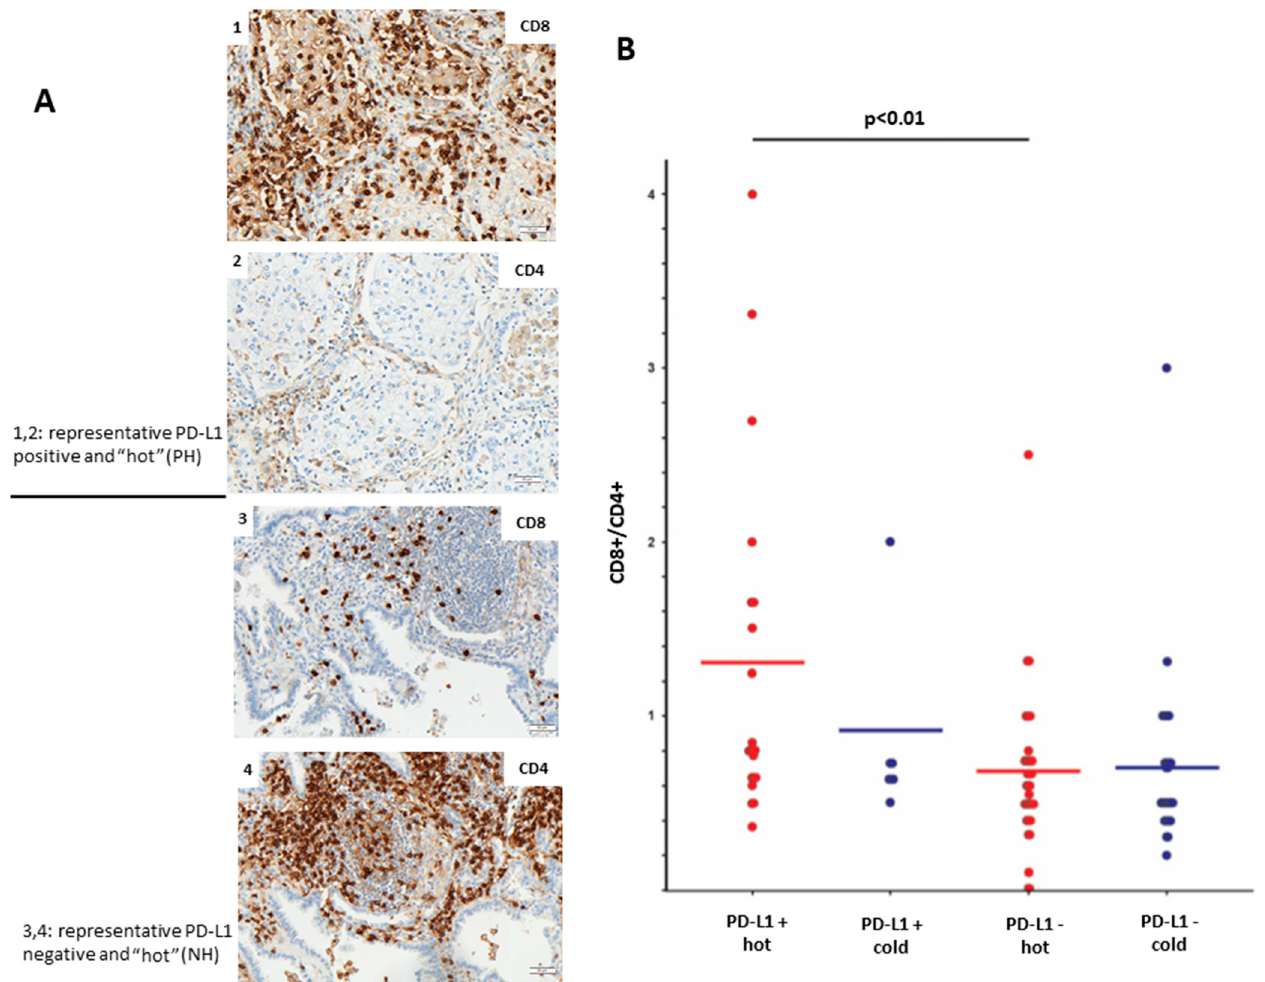
Figure 3. Relation between PD-L1 expression and immune infiltration. ( A ) Representative images of CD8 and CD4 expression in PH LUAD (lane 1,2) and NH LUAD (lane 3,4) (objective magnification ×10; scale bar = 50 μ m). ( B ) CD8/CD4 quotient of the four groups showing that increased cytotoxic T-cell presence depends on PD-L1 expression and high total immune infiltration. Scale bar: 50 μ m